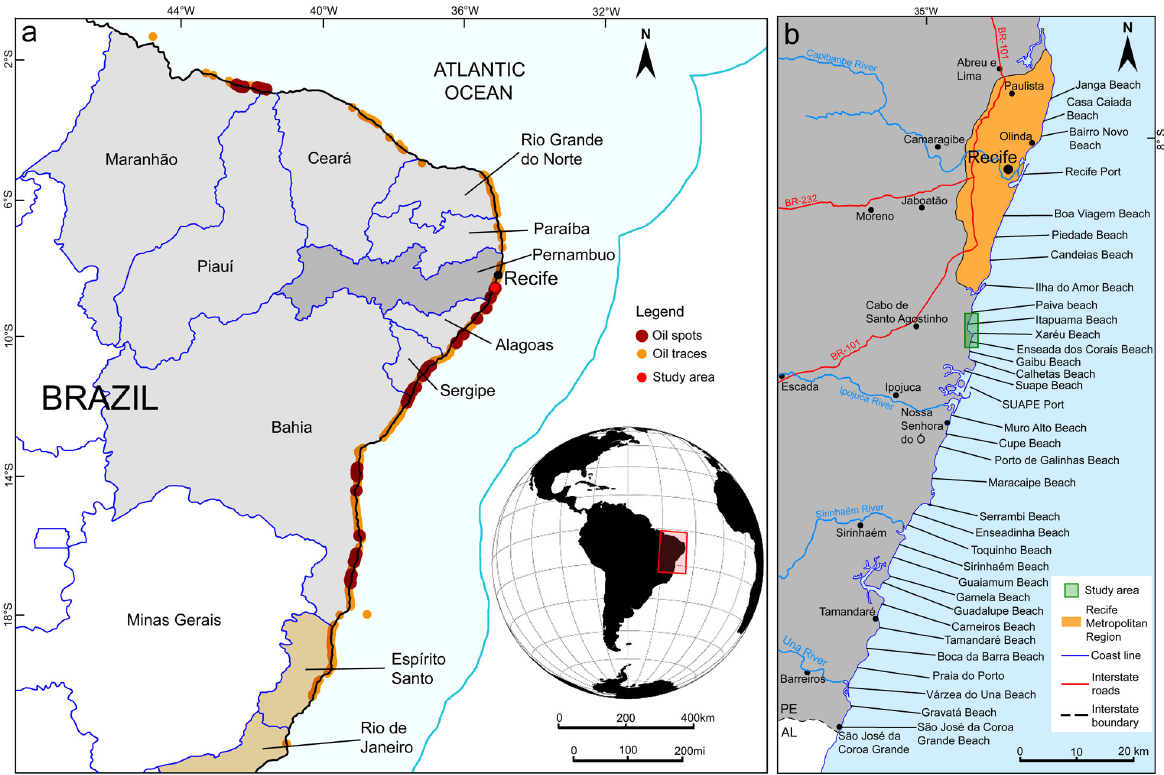
Figure 1. a) Map showing the distribution of contaminated areas along the Brazilian coastal zone until the end of 2019 caused by the offshore oil spill (IBAMA 2020, Gonçalves et al. 2020), which impacted nine states of northeastern Brazil (gray) and two states of the southeast margin (brown). The light blue zone marks the exclusive economic zone. The insert shows the impacted region on the eastern margin of South America. b) The southern coast of Pernambuco state and the study area is shown by the green